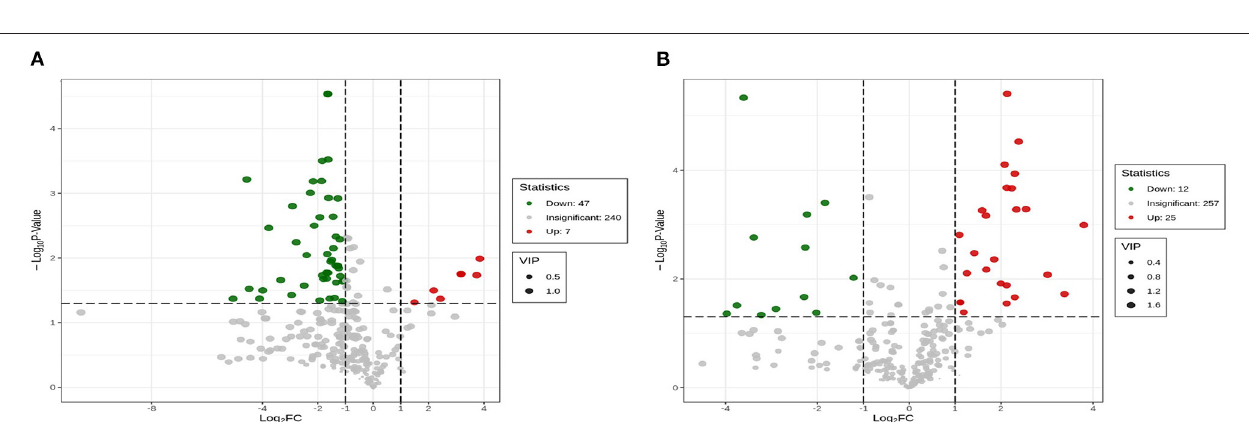
Frontiers in Nutrition |